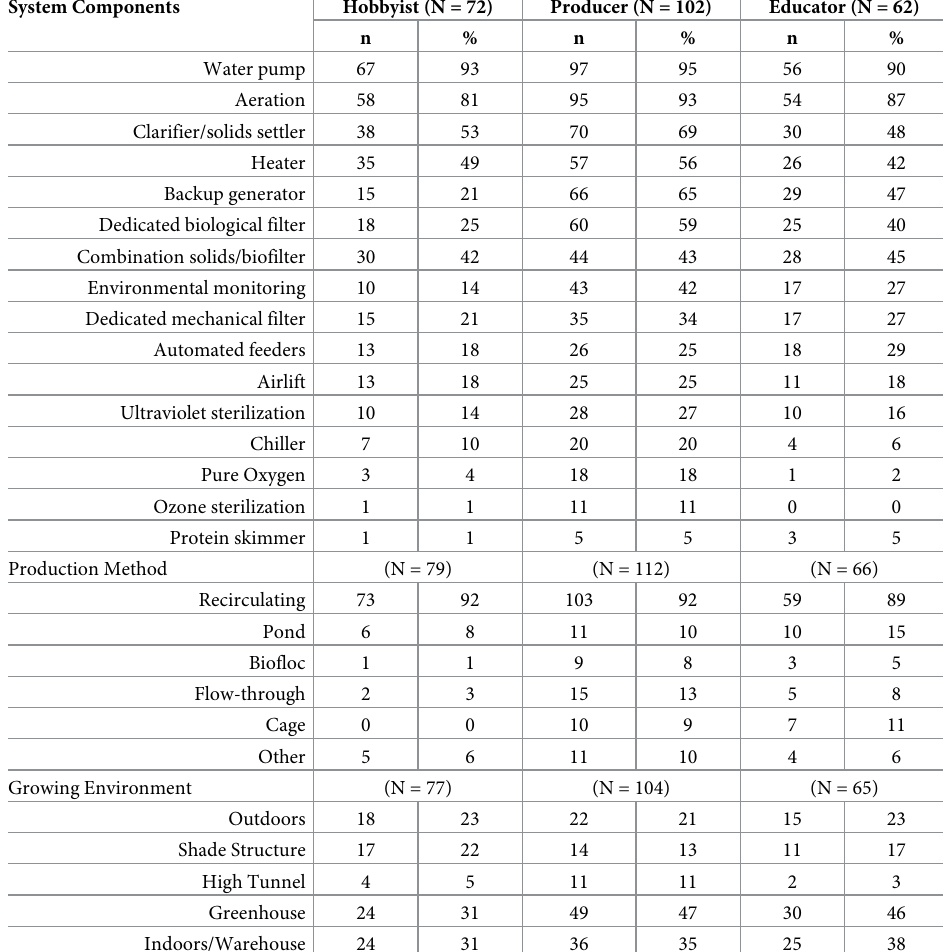
Table 1. Aquaculture system components incorporated into aquaponic systems by hobbyists, producers, and